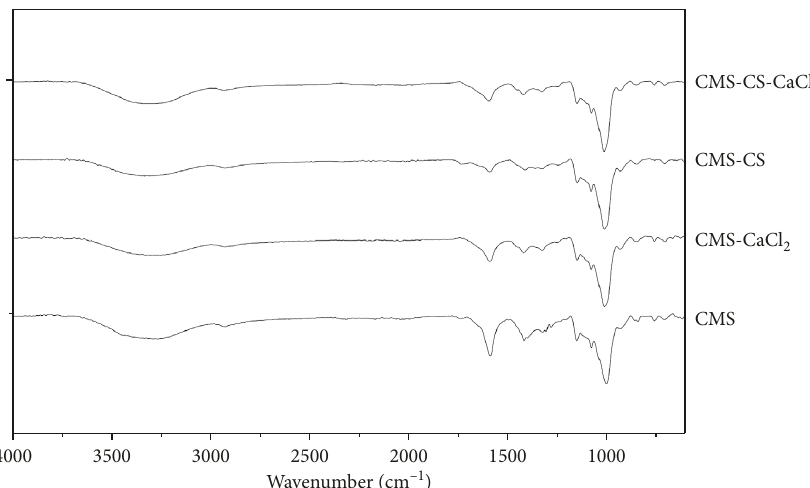
Figure 11: FTIR Spectra from hydrogel samples made of CMS (a) 3.2% by (b) ionotropic gelation with CaCl complexation with CS 0.01% w/v, and (d) combination of ionotropic gelation and polyelectrolyte